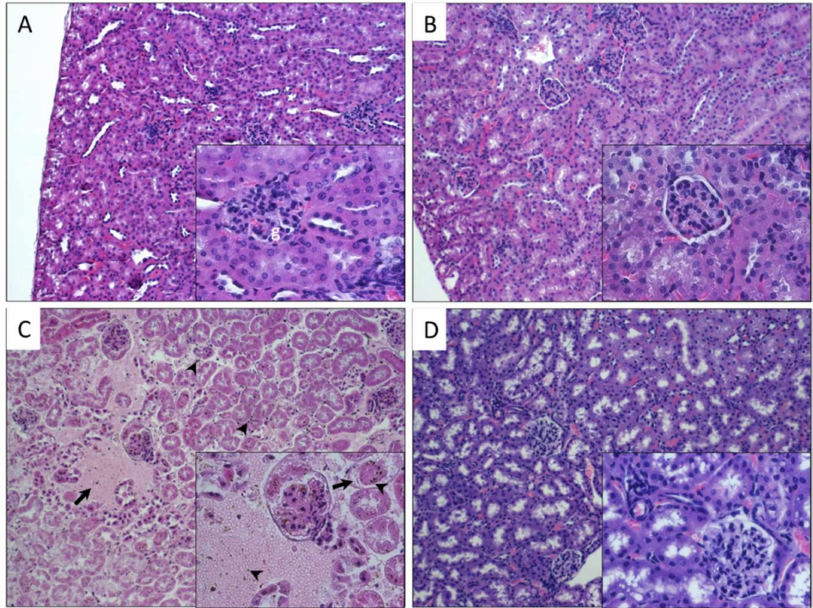
Figure 4. Histopathological findings in kidney of mice exposed to di ff erent types of CNTs. Microphotographs show kidney sections of mice exposed to: A , control group non exposed, the normal morphology of renal cortex ( g , glomerulus); B , P-CNTs exposed group. C , UP-CNTs exposed group, hemorrhagic areas (arrows) and small spherical bodies trapped in glomeruli and damaged areas (arrowheads) that corresponds to UP-CNTs. D , FITC-CNTs exposed group. Microphotographs are representative of one experiment. Magnifications 10 × . Insets show magnification at 40 × . H&E